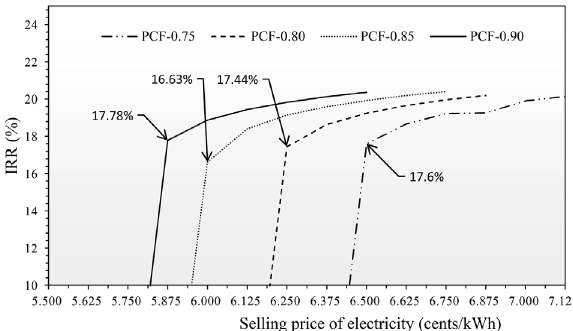
Figure 5. Variation of NPV with selling price of electricity consid - ering high O&M costs-14.5$/MWh and fuel costs-11.2$/MWh, discount rate-10% and PCFs-75, 80, 85, and 90% (Case 5 to